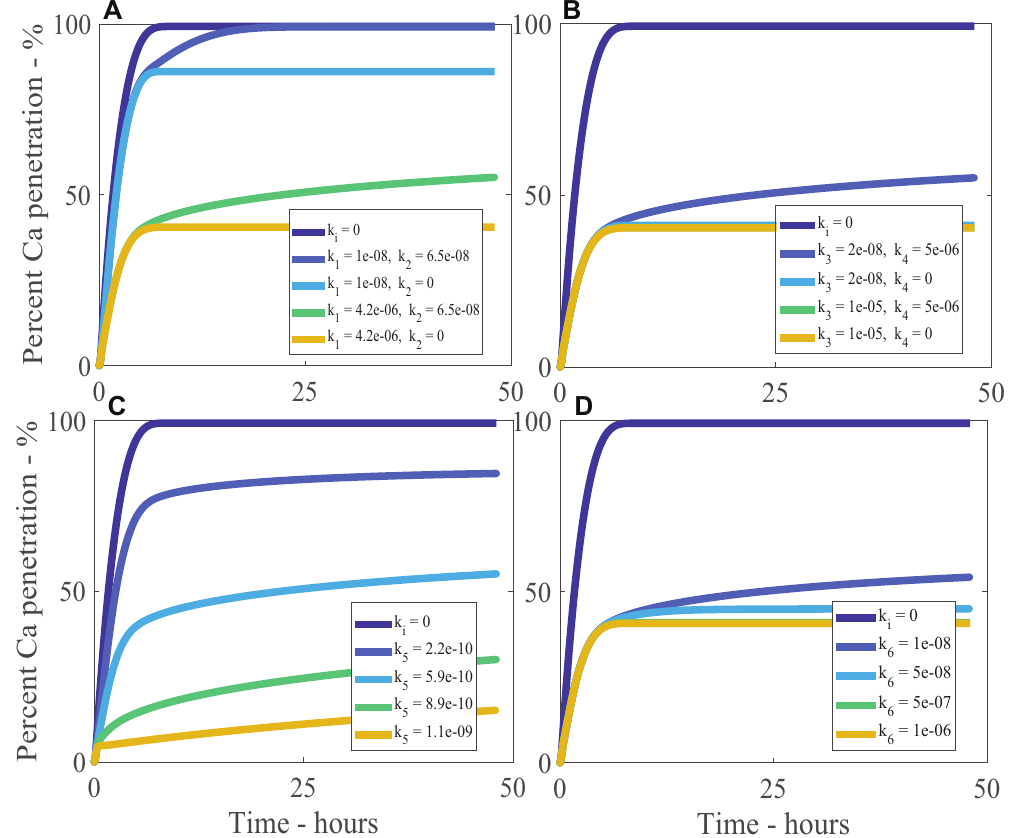
Figure 5. Percentage of calcium (Ca) penetration sensitivity to k 1 and k 2 ( A ), k 3 and k 4 ( B ), k 5 ( C ) and k 6 ( D ), with parameters described in Table 1 at an initial concentration of CaCl 1 g/L. The kinetic rate constants for the ionic AI are k 1 and k 2 ( A ) and k 5 ( C ). The kinetic rate constants for the lipophilic adjuvant are k 3 and k 4 ( B ) and k 6 ( D